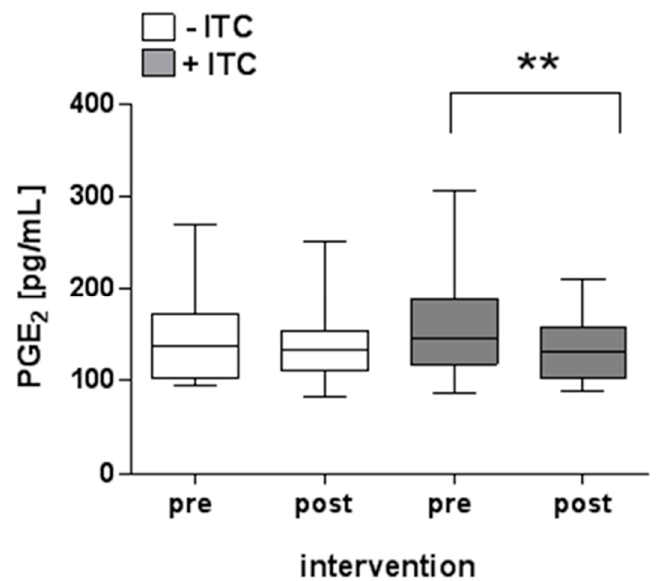
Figure 5. Effects of B. carinata intervention on prostaglandin E 2 (PGE 2 ) plasma levels. White boxes show the PGE 2 plasma concentration before (pre) and after (post) intervention with the preparation from cooked B. carinata leaves ( − ITC), and grey boxes show the PGE 2 plasma concentration before (pre) and after (post) B. carinata intervention with the preparation from raw B. carinata leaves (+ITC) as pg/mL − ITC: n = 18; +ITC: n = 20. Outlier removed. Minimum and maximum values, lower and upper quartiles, and median values are given. Asterisks indicate statistically significant differences (** p ≤ 0.01; Wilcoxon matched-pairs signed rank test).